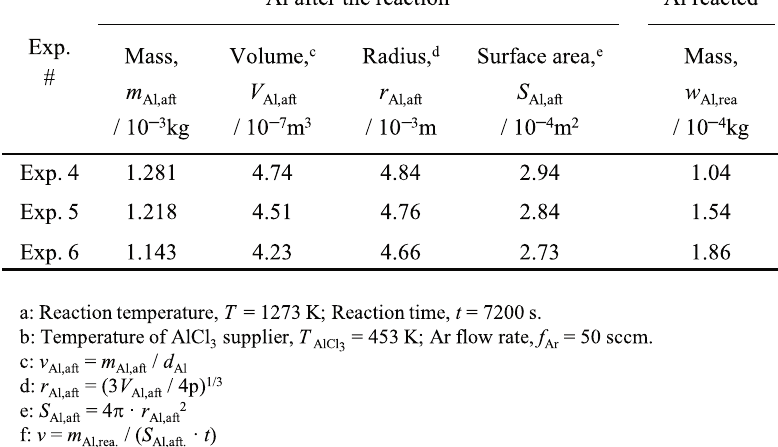
Table 6. Nominal reaction rate for formation of aluminum subchlorides. a,b